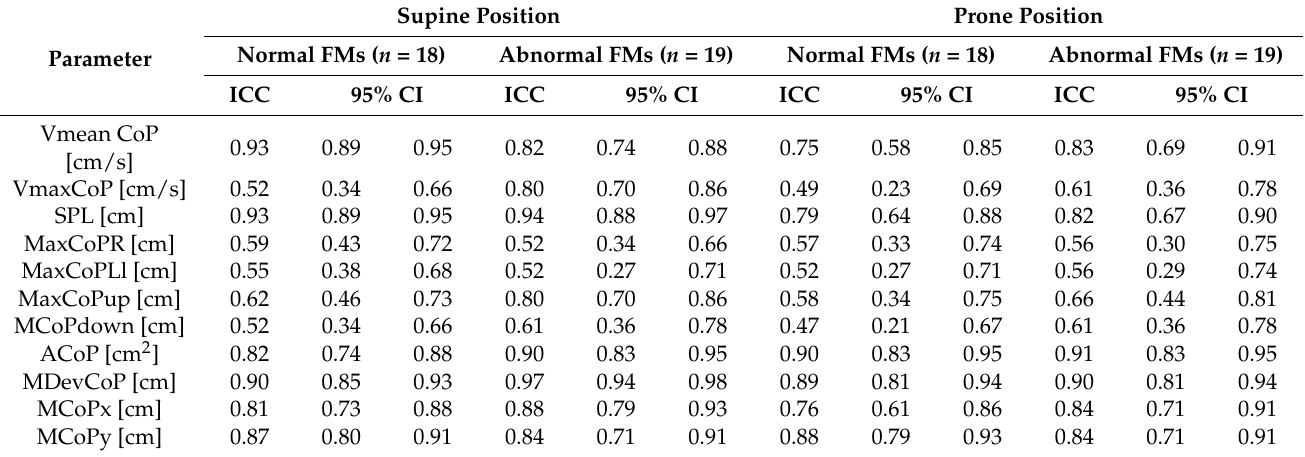
Table 6. Intraclass correlation coefficients for the first and second measurements of individual parameters describing the spontaneous sway of CoP and the area of CoP in the groups of infants who presented with normal and abnormal FMs in PT in prone and supine positions. Supine Position Prone Parameter